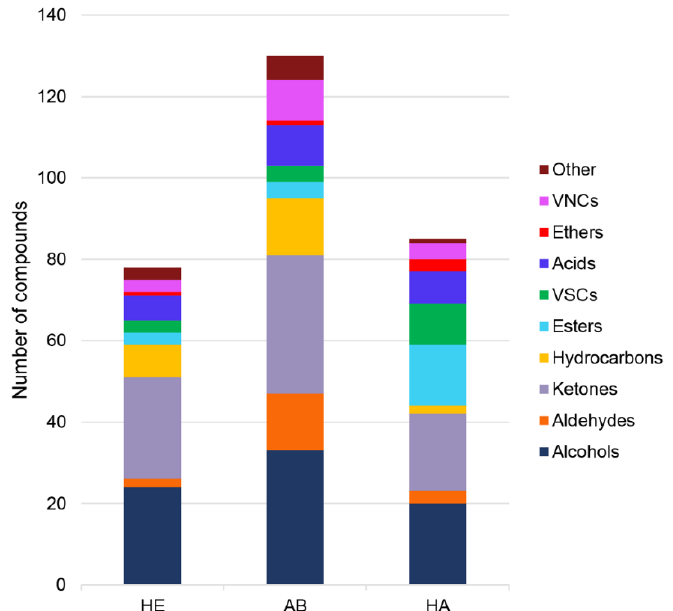
Figure 1. Functional group distribution of VOCs (volatile organic compounds) for healthy patients (HE), subjects with submandibular abscesses (AB), and halitosis (HA), where: VNCs—volatile nitrogen compounds, VSCs—volatile sulfur compounds.